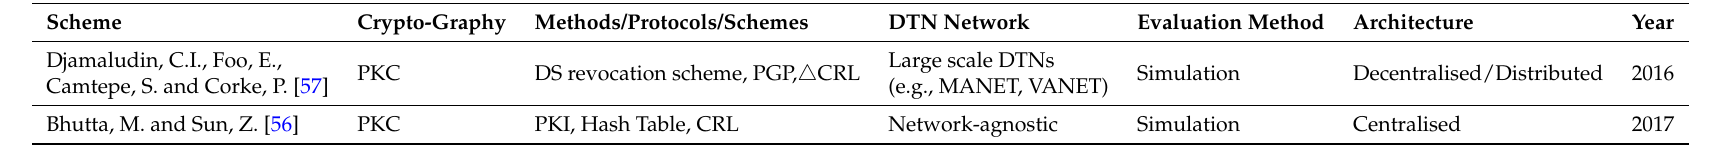
Table 5. Comparison of key revocation